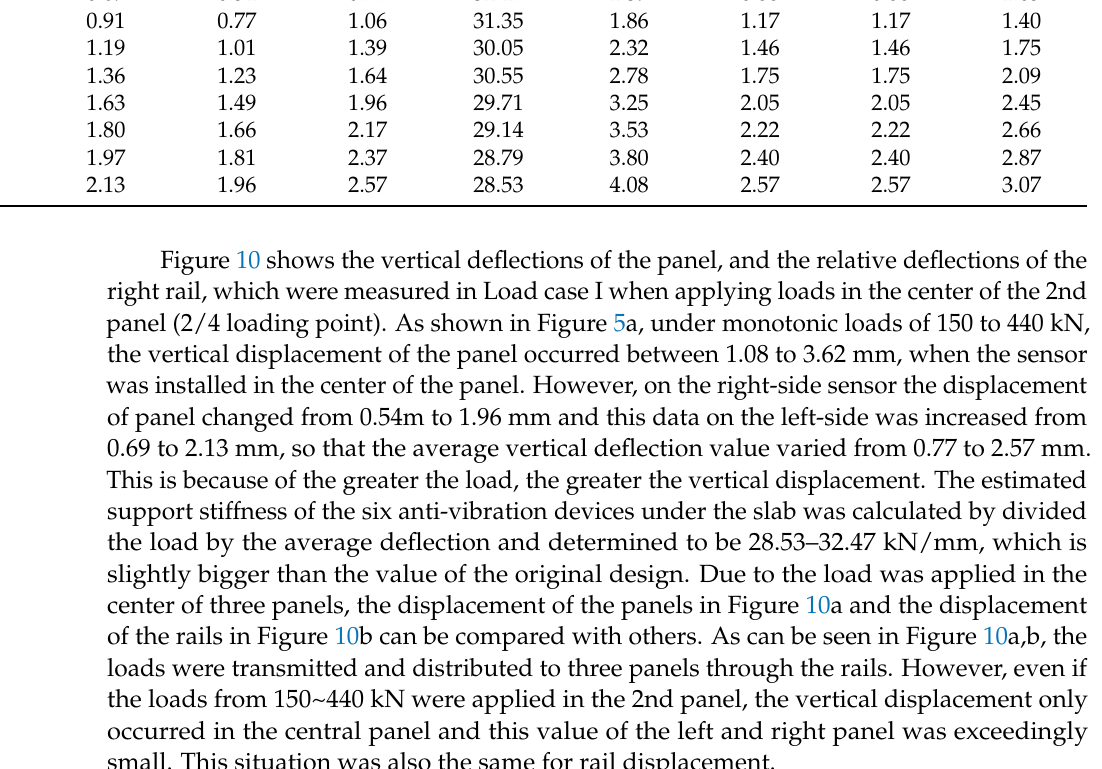
Table 4. Panel vertical displacement of three-panel precast floating slab track panel (central loading point in 2nd Panel). Panel Vertical Displacement Load (kN) 150